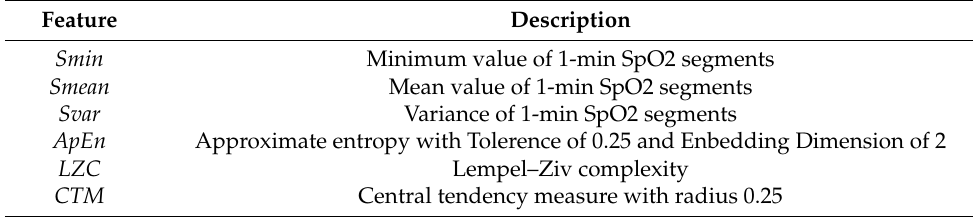
Table 2. SpO2 features and their